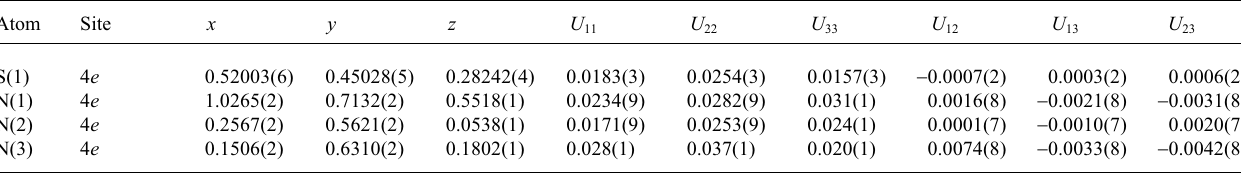
Table 3. Atomic coordinates and displacement parameters (in Å 2